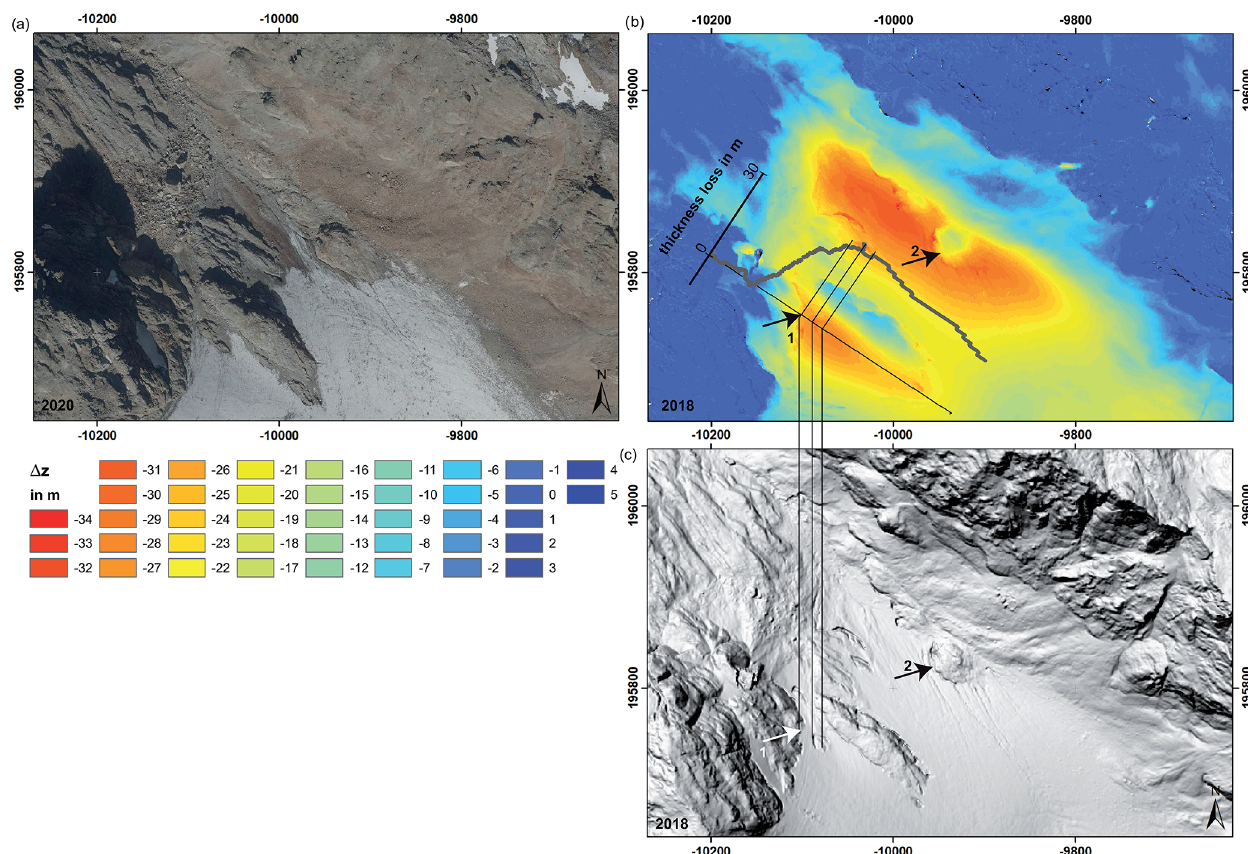
Figure 7. The glacier margins of Schnapfenkuchl M terminus illustrated in the 2020 orthophoto (a) was mapped from thickness changes ( (cid:49)z ) between 2004 and 2017 (b) . A characteristic pattern of thickness loss indicates the position of the glacier terminus and rock outcrops: the total thickness loss of areas where the ice is gone between t 1 and t 2 is smaller than that for the ice margin at t 2 (position at t 2 indicated by the arrows 1 and 2). The hillshade of the 2018 DEM (c) provides an additional source of information as the glacier surface tends to be smoother than the surrounding area. Source orthophoto: CC 4.0